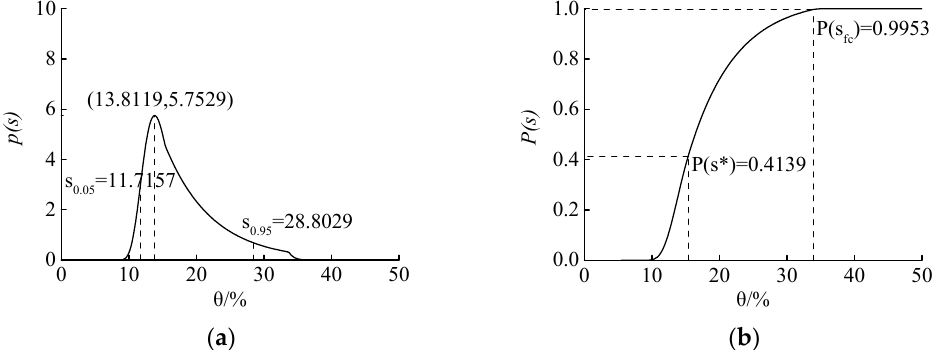
Figure 7. PDF ( a ) and CDF ( b ) of the soil moisture during the validation period. ( a ) PDF of soil moisture; ( b ) CDF of soil moisture.